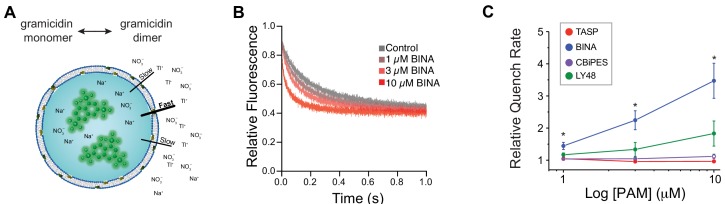
Analysis of the effects of G protein on LY48-induced inter-TMD FRET kinetics.(A) Schematic describing liposome-based membrane interaction assay using gramicidin as a sensor of membrane properties. The gramicidin monomer↔dimer equilibrium varies with changes in lipid bilayer properties, such as thickness and elasticity. Shifts toward the right will increase the number of conducting dimers, which can be detected by measuring the rate by which the gramicidin channel permeant heavy ion quencher thallium (Tl+) quenches intravesicular fluorophores like 8-aminonaphthalene-1,3,6-trisulfonate (ANTS). (B) Representative fluorescence quench traces recorded by mixing ANTS-loaded LUVs that have been equilibrated with BINA at the indicated concentrations with a Tl+-containing solution in a stopped-flow spectrofluorometer. (C) Dose–response curves for all PAMs showing relative effects on quenching rate in fluorescence membrane interaction assay. * indicates statistical significance (unpaired t-test with Holm-Sidak correction, p=0.2 for 1 µM BINA, p=0.02 for 3 µM BINA and p=0.03 for 10 µM BINA). Values come from at least three separate measurements per conditions. Error bars show s.e.m.